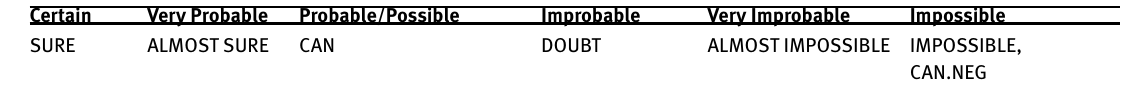
Table 3: objective epistemic scale in LSE Certain Improbable Very